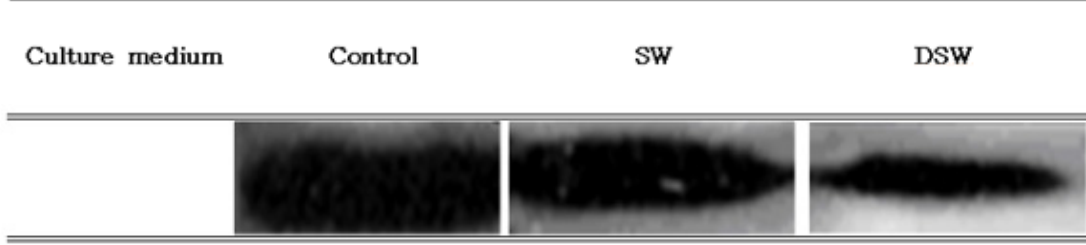
Figure 3. The expression of Bcl-2 in A549 cells after adding 1.0 mg/mL of the extract of S. maxima grown in different media. (SW: seawater, DSW: deep-sea